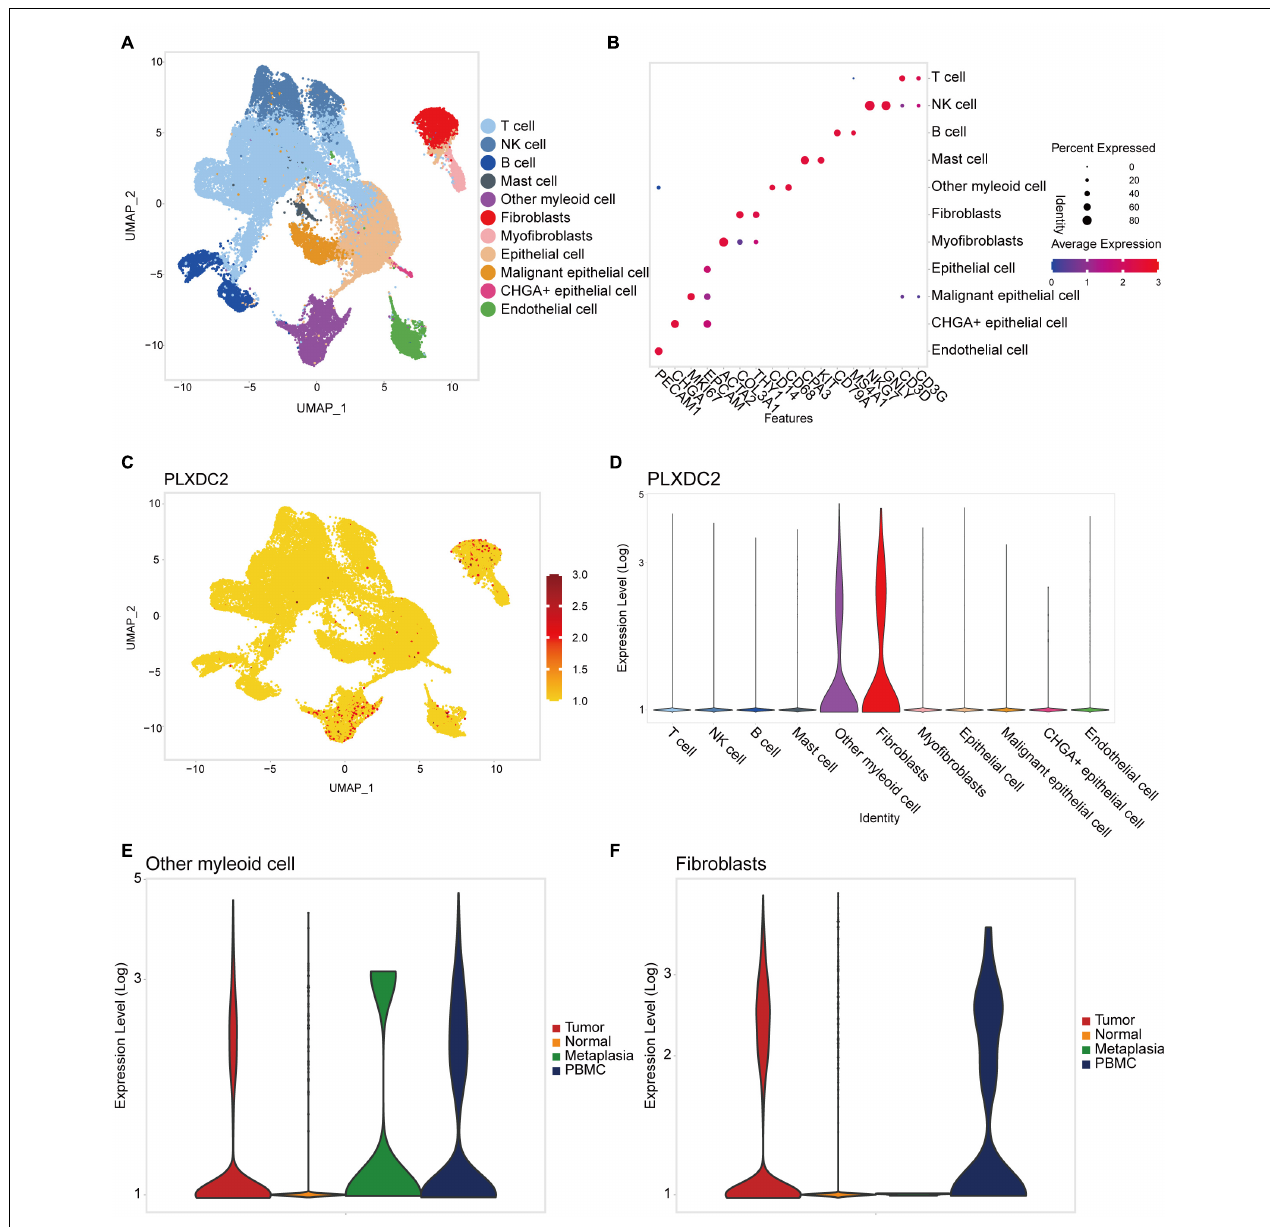
FIGURE 6 | PLXDC2 expression level ascend in Fibroblasts and Macrophages. (A) Uniform manifold approximation and projection (UMAP) dimensionality reduction analysis. 11 cell types were identified with its unique gene marker. Other myeloid cell represents monocytes and macrophages. (B) Bubble plot demonstrating each cell type and its gene marker. (C) UMAP revealing the expression level of PLXDC2. Higher expression is indicated with a redder color. (D) Violin plot showing the expression of PLXDC2 in each cell type. (E) Violin plot showing the expression level of PLXDC2 in other myeloid cell of Metaplasia, Normal, PBMC and Tumor samples, metaplasia represents the transformation of one differentiated cell type to another differentiated cell type, and PBMC resembles peripheral blood mononuclear cell. (F) Violin plot showing the expression level of PLXDC2 in fibroblasts of Metaplasia, Normal, PBMC and Tumor samples, similar to (E)